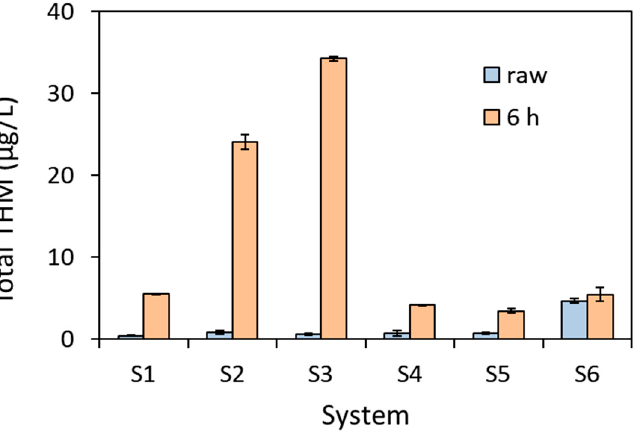
Figure 2. Total trihalomethane concentrations in raw water and water treated for 6 h.